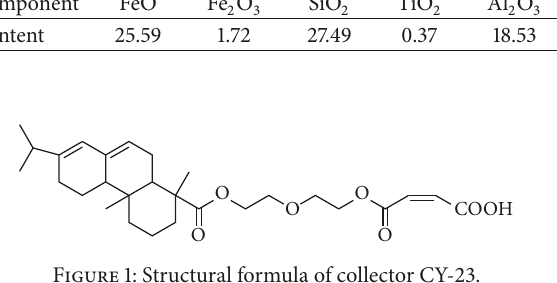
Figure 1: Structural formula of collector